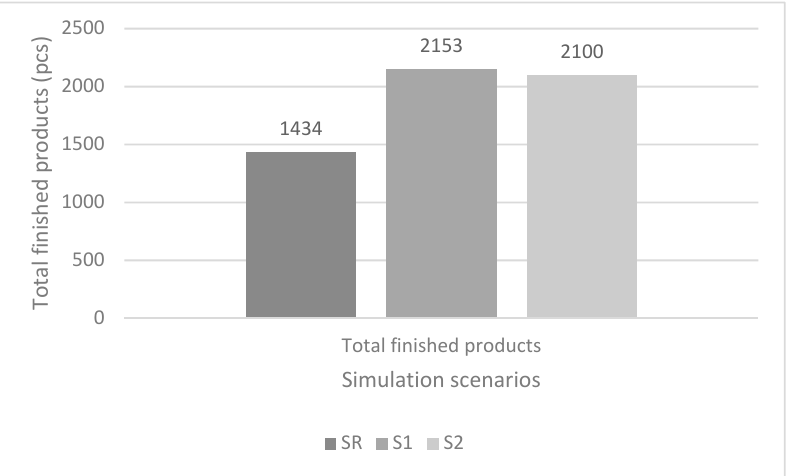
Figure 7. Total finished products simulation scenarios’ comparison. Table 4. Simulation scenarios result presenting workplace costs’ evaluation.